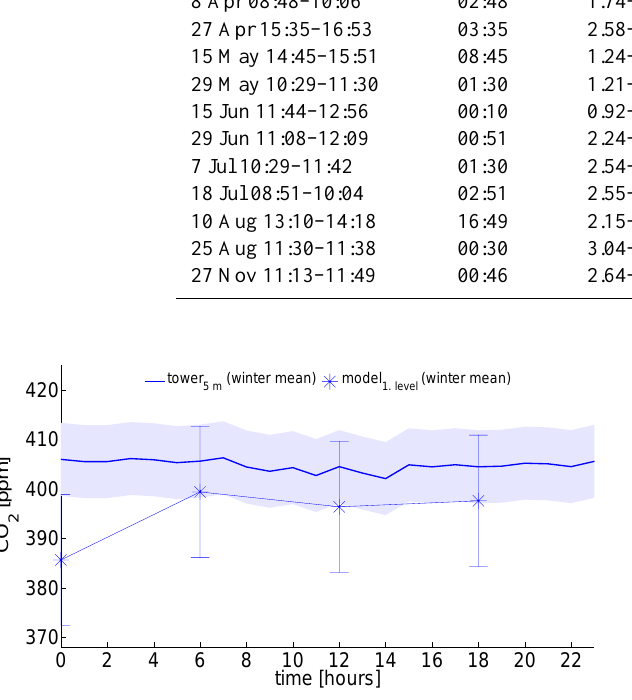
Fig. 11. Mean diurnal cycle for the winter. The blue curve shows the mean diurnal cycle at the tall tower level of 5m (1 σ standard deviation shown shaded in blue). The mean model outputs are given as blue stars (1 σ standard deviation as error estimation). The model underestimates the CO 2 concentration, especially in the night.